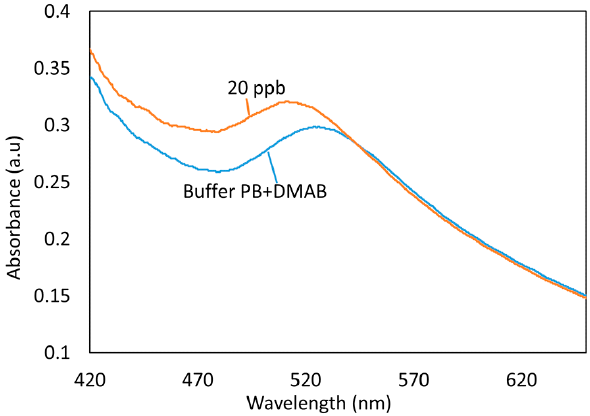
Figure 4. Displacement in wavelength of the LSPR for 20 ppb of mercury concentration.